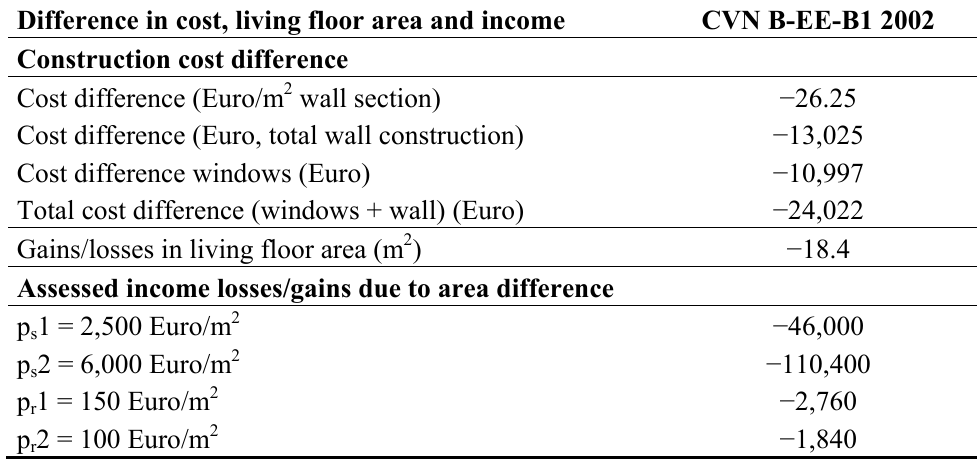
Table 6. Cost difference and assessed living area lost between conventional and energy-efficient building constructed in 2002, brick house.